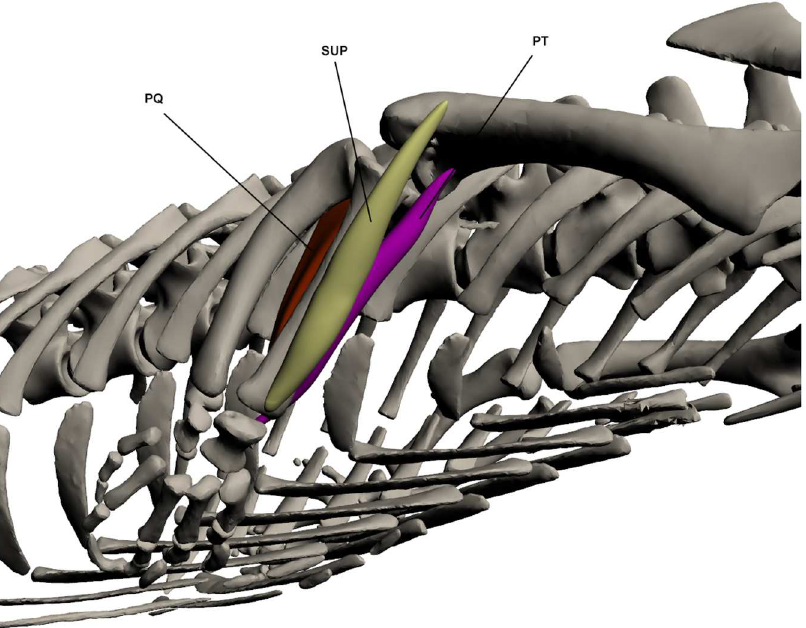
Fig 11. Intrinsic muscles of the forelimb: pronators and supinators of the forearm. PQ: Pronator quadratus , SUP: Supinator , PT: Pronator teres